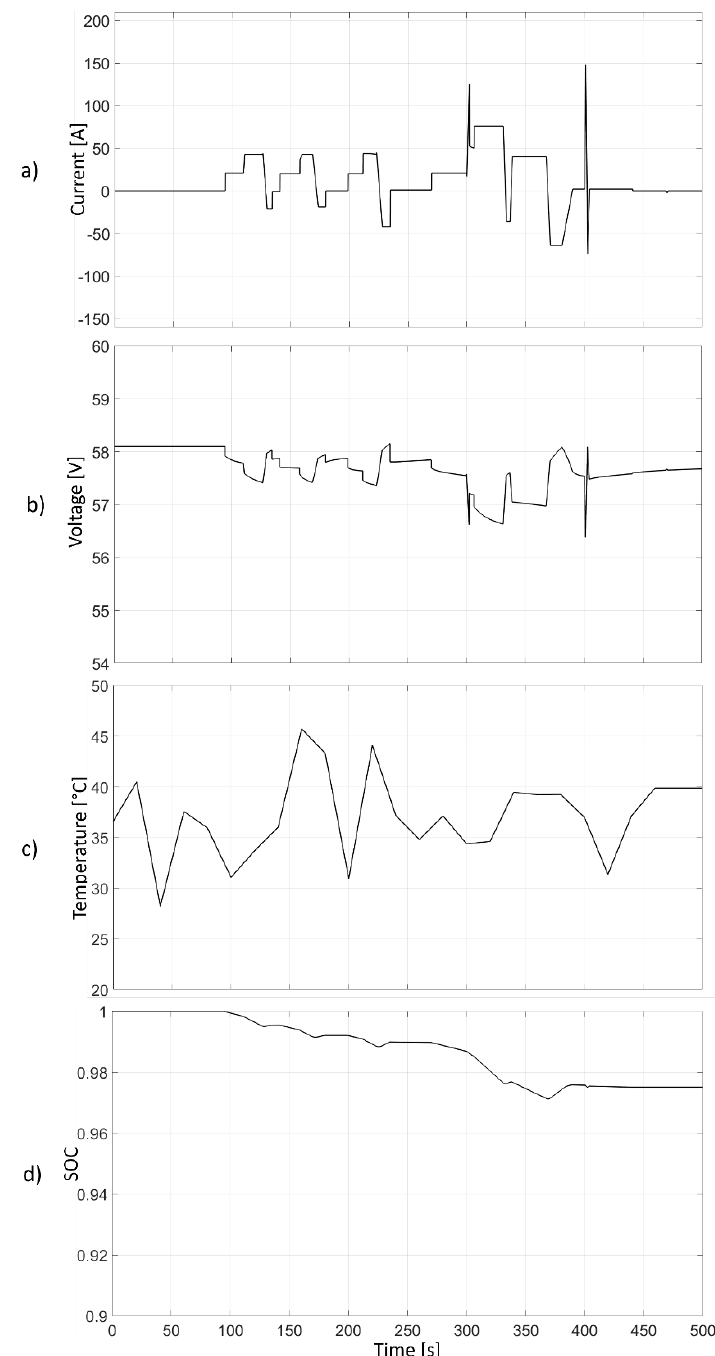
Figure 5. Test dataset obtained as a portion of the “United States Advanced Battery Consortium” (USABC) PHEV dynamic charge depleting duty cycle profile: ( a ) Current charge / discharge. ( b ) Voltage. ( c ) Temperature. ( d ) State of Charge.